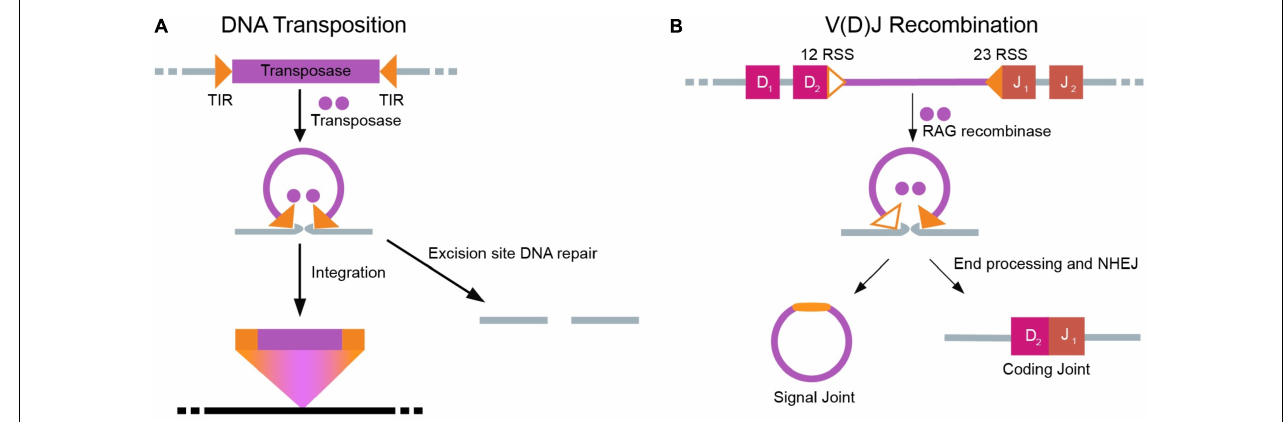
FIGURE 3 | Parallel mechanisms of DNA transposition and V(D)J recombination. (A) Self-encoded transposases excise a DNA transposon, including flanking terminal inverted repeats (TIRs). Subsequently, the transposon inserts into a new DNA sequence. The excision site must now be repaired through host DNA repair machinery. (B) In V(D)J recombination, V, D, and J segments are separated by intervening recombination signal sequences (RSSs) with similarity to transposons TIRs. RAG1/RAG2 recognize the RSS using the 12–23 rule, enabling cleavage of the intervening segment. The two ends of DNA that are separated (D and J ends as shown here) are subsequently joined through end processing and NHEJ to form the signal and coding